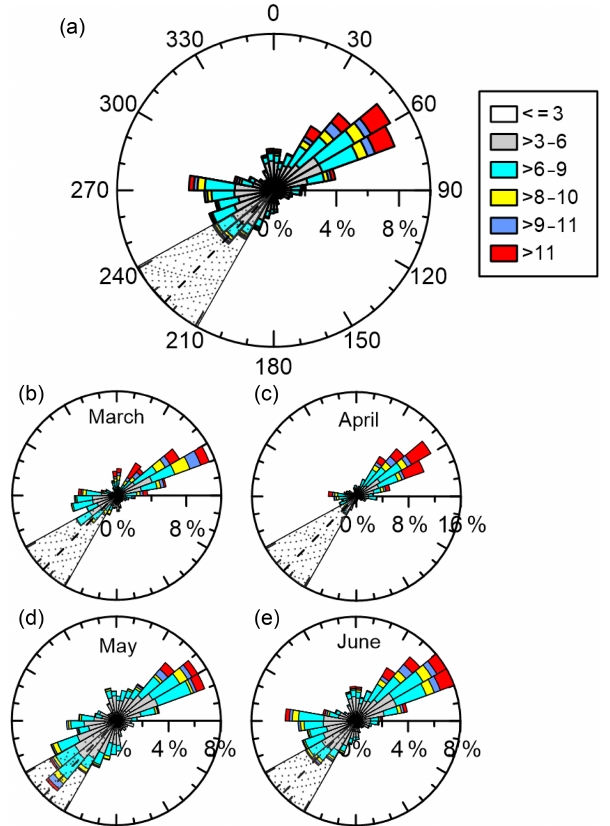
Figure 8. Panel (a) : wind rose from 78m height at Tower 20 (loca- tion shown Fig. 1) for all 10min periods during March–June 2017. Coloured bars show the wind speed (in ms − 1 ). Panels (b–e) : wind rose for each month. The shaded grey area shows the primary wake directions (209–241 ◦ ), with the wake centre line direction of 227 ◦ being marked with the black dashed line.